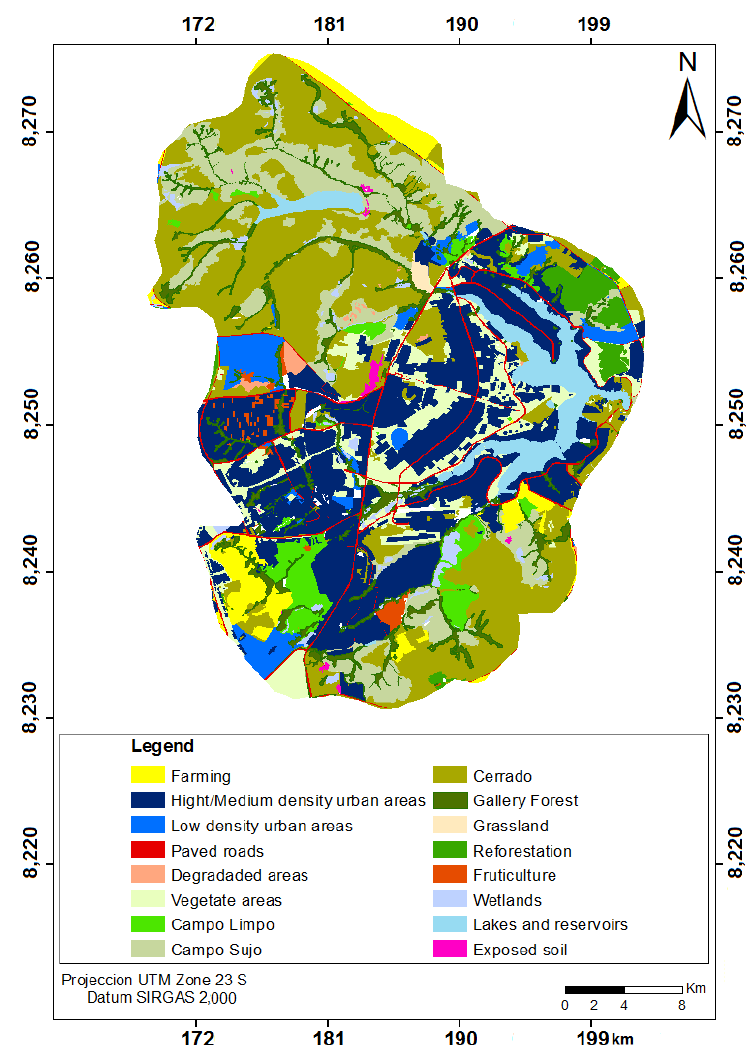
Figure 2. Land use and occupation of Lake Parano á catchment area (adapted) [28].